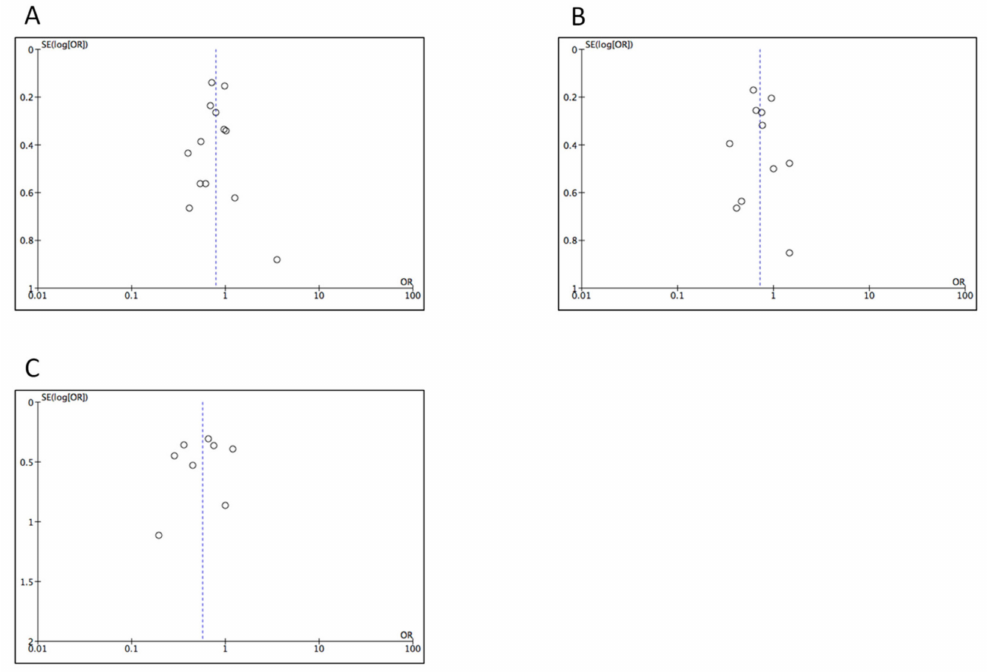
Figure 5. Funnel plot of survival outcomes ( A ) 1-year OS. ( B ) 3-year OS. ( C ) 5-year